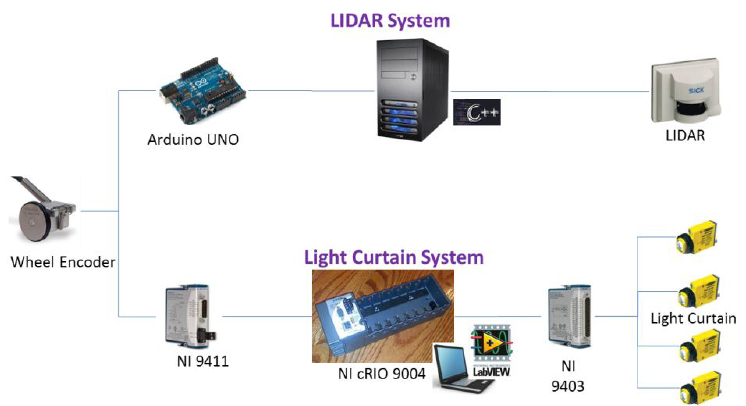
Figure 2. Devices and software used the two